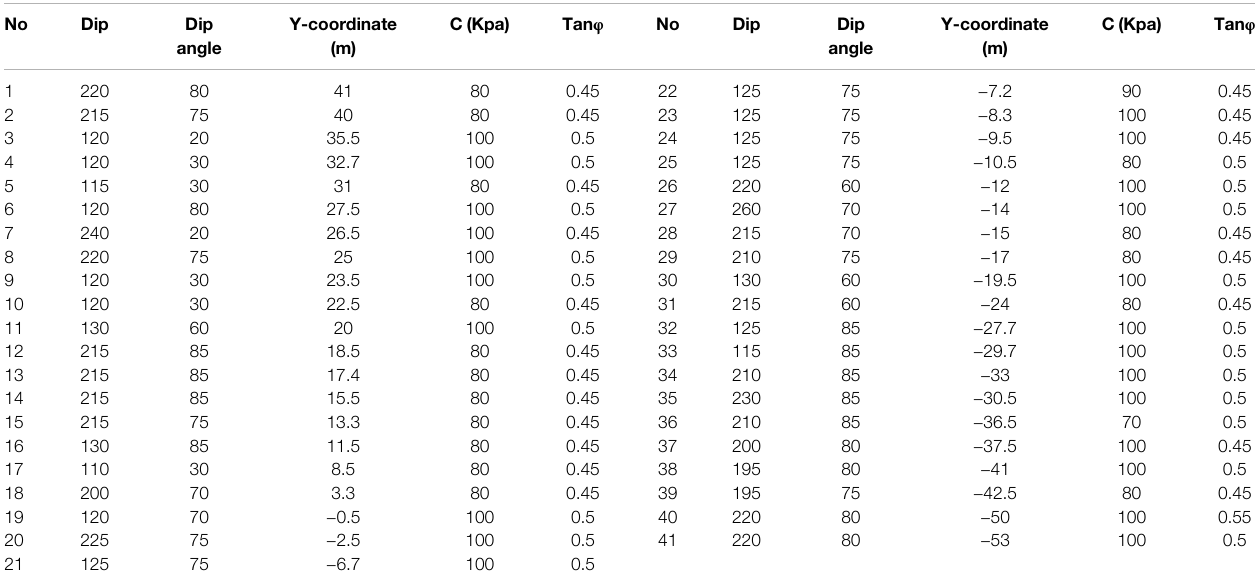
TABLE 1 | The parameters of the